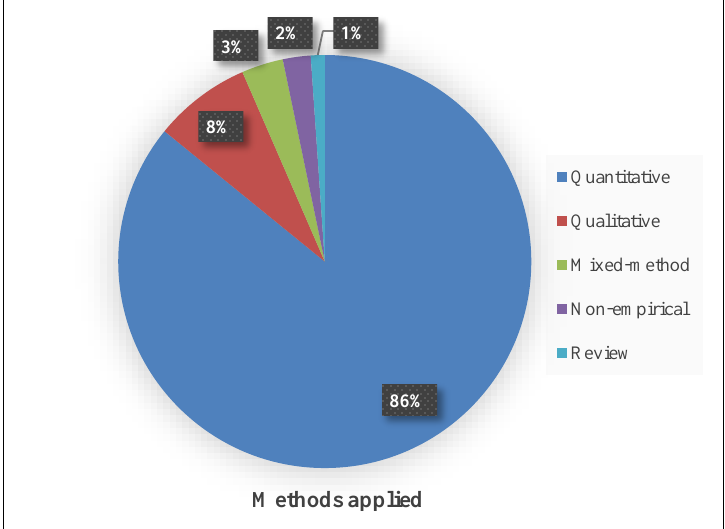
Figure 4. Methodologies applied in the sample